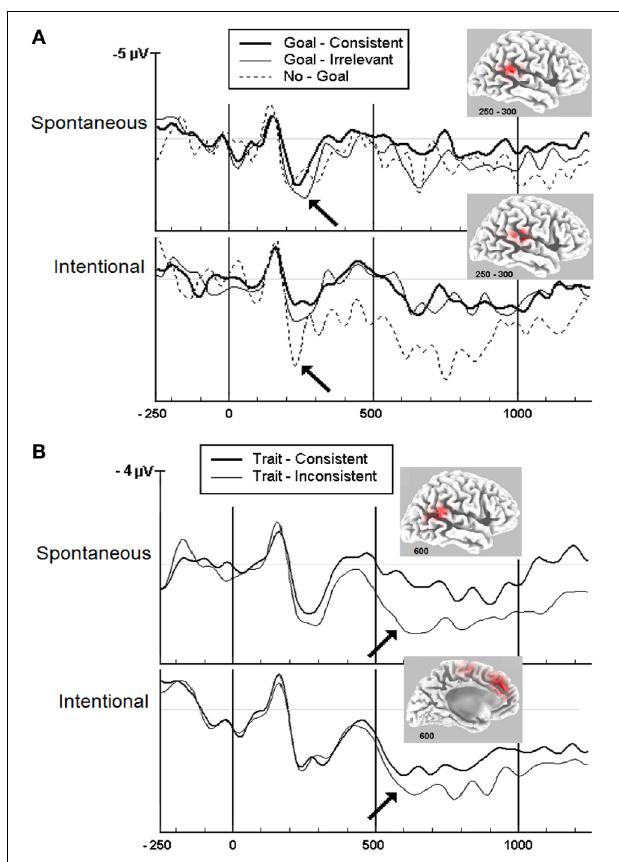
FIGURE 1 | Grand-averaged ERP waveforms showing positive deflections at the central midline (Cz) scalp sites given spontaneous and intentional instructions. The timeline is given in ms. A positive amplitude is shown downward. (A) Goal inferences: Goal-consistent words diverge significantly from goal-irrelevant and no-goal words at about 250ms ( p < 0 . 05) as indicated by the arrows. Insets: LORETA source analysis of the TPJ at 250–300ms. Adapted with permission from Van der Cruyssen et al. (2009). Copyright 2008 by Psychology Press. (B) Trait inferences: Trait-consistent words diverge significantly from trait-inconsistent words at about 600ms ( p < 0 . 05) as indicated by the arrows. Insets: LORETA source analysis of the TPJ and mPFC at 600ms. Adapted with permission from Van Duynslaeger et al. (2007). Copyright 2007 by Oxford